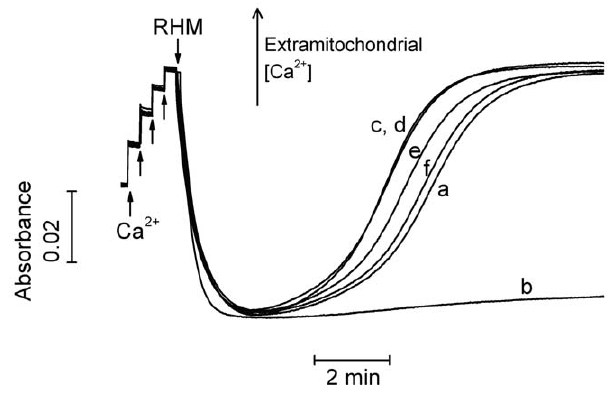
Figure 3. PD153035 does not decrease mitochondrial Ca 2 + uptake, nor prevent permeability transition. Isolated rat heart mitochondria (RHM; 0.5 mg/mL) were incubated in 125 mM sucrose, 65 mM KCl, 10 mM HEPES, 2.5 mM KH 2 PO 4 , 40 m M arsenazo III, 1.25 mM malate, 1.25 mM glutamate, 1.25 mM pyruvate and 1.25 mM a -ketoglutarate, pH 7.2 (KOH). Ca 2 + was added where indicated in four